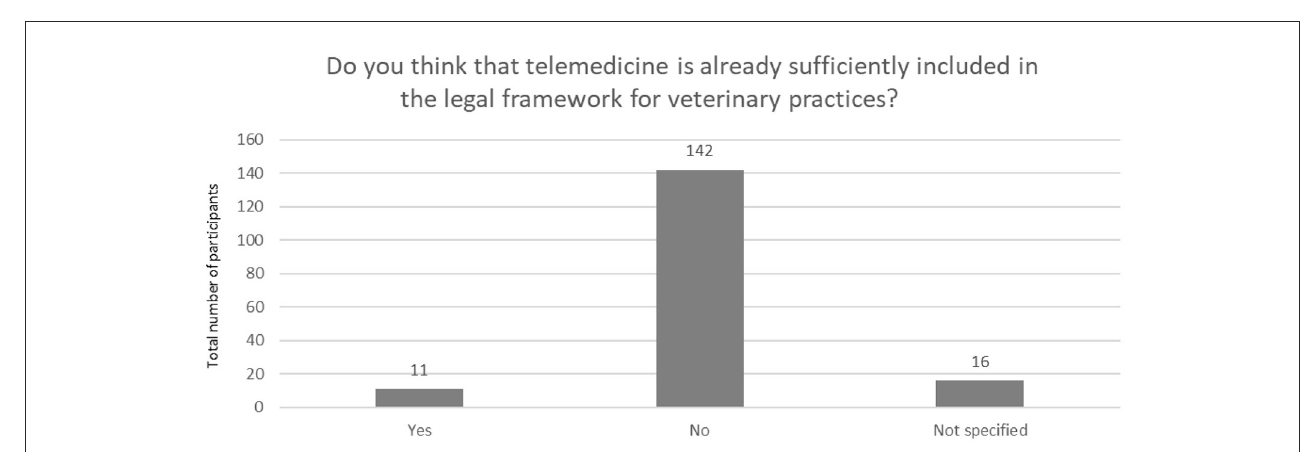
FIGURE8 Inclusion of veterinary telemedicine in the legal framework for veterinary practices ( N =